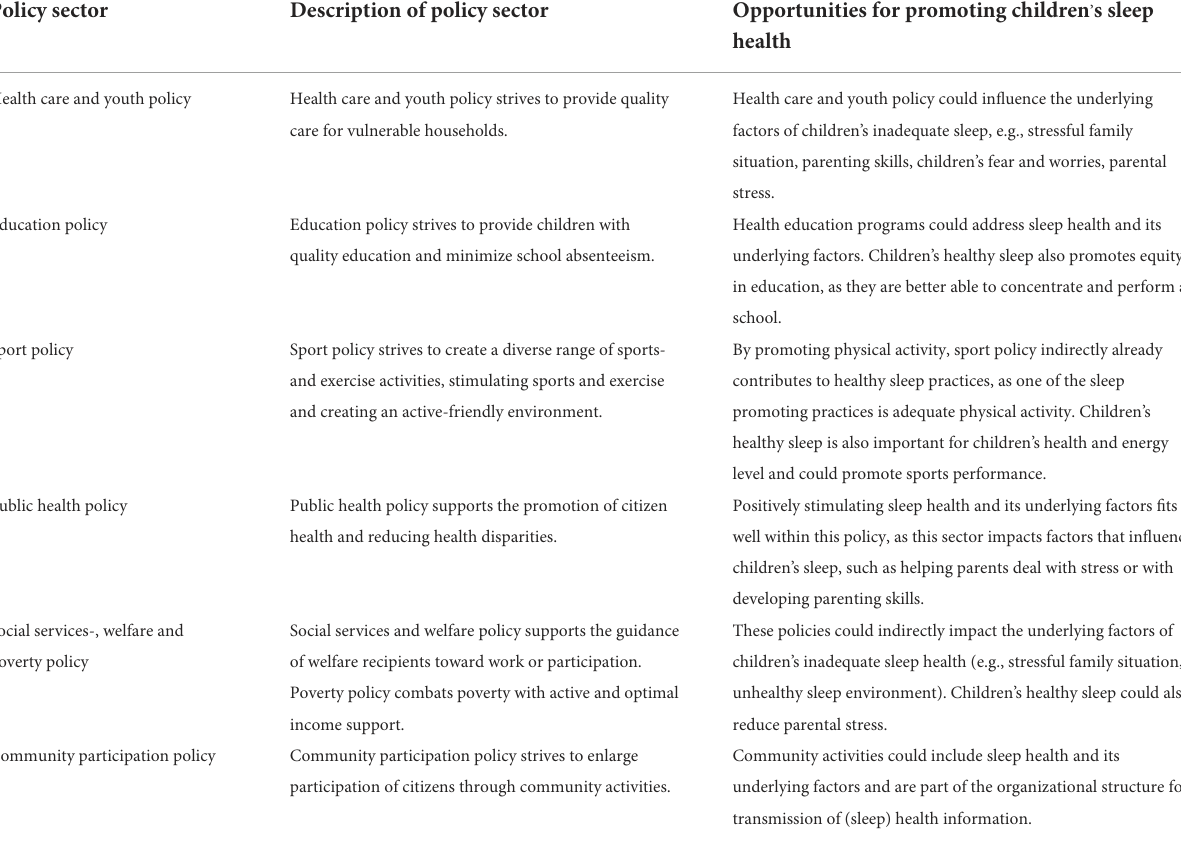
TABLE 3 Opportunities for sleep health in all policies for local policy in